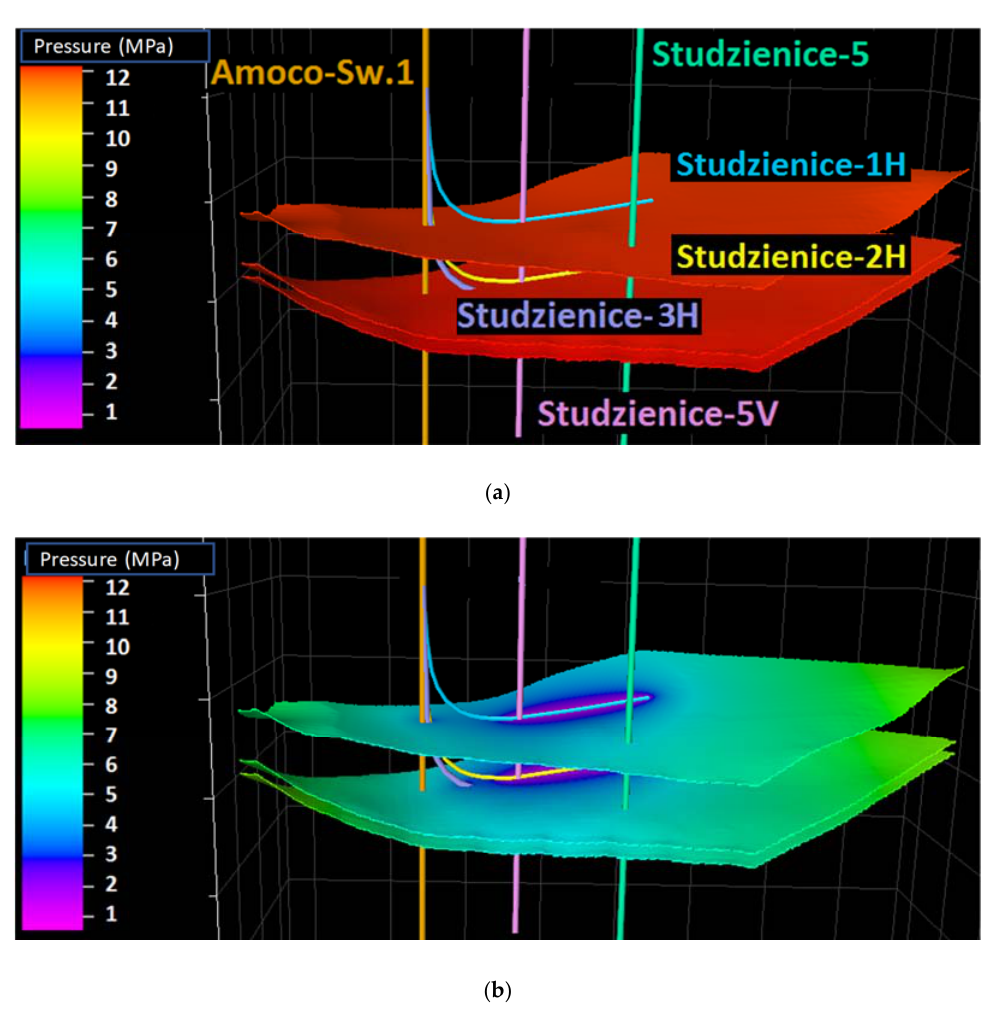
Figure 7. Distribution of pressure in coal seams ( a ) before the simulation and ( b ) after 5 years of methane extraction (end of the simulation).